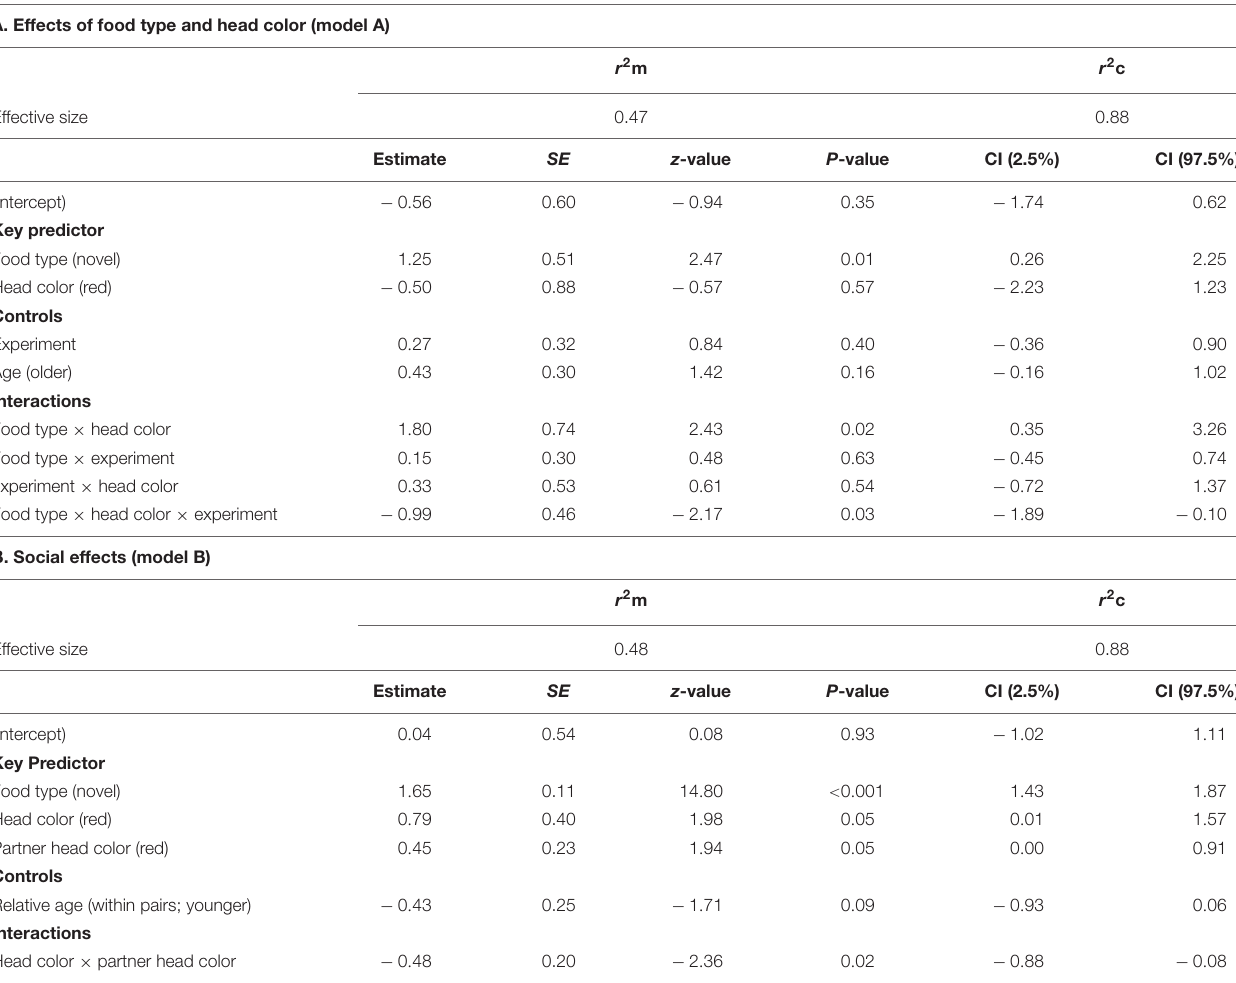
TABLE 2 | Results of the general linear mixed effects model on the number of approaches before first feed on familiar and novel food of Gouldian finches addressing (A) the effect of food type and color morphs (model A) and (B) social effects (model B). Only the final model of each analysis is shown. The reference modality is in parentheses.